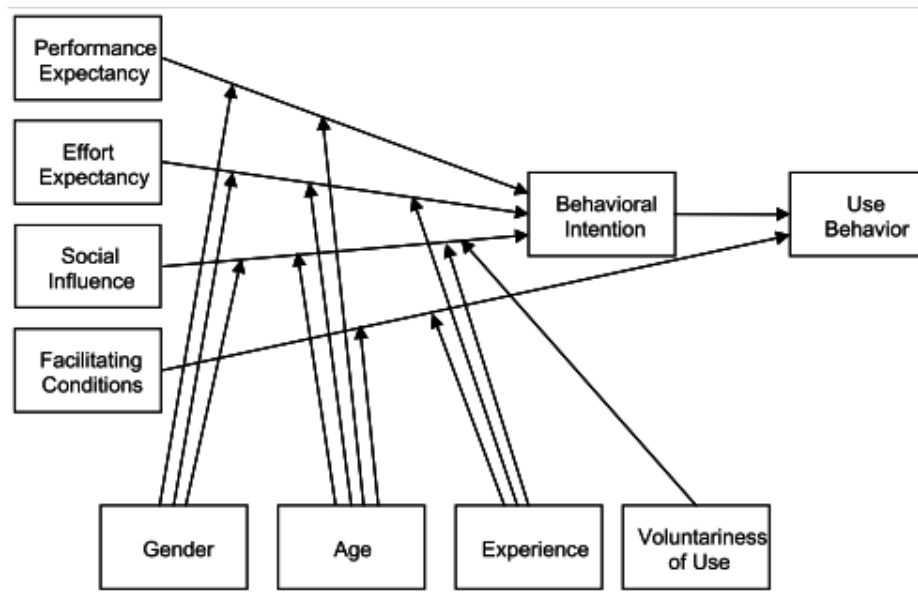
Figure 1 . The UTAUT model (Source: Venkatesh et al., 2003, p.